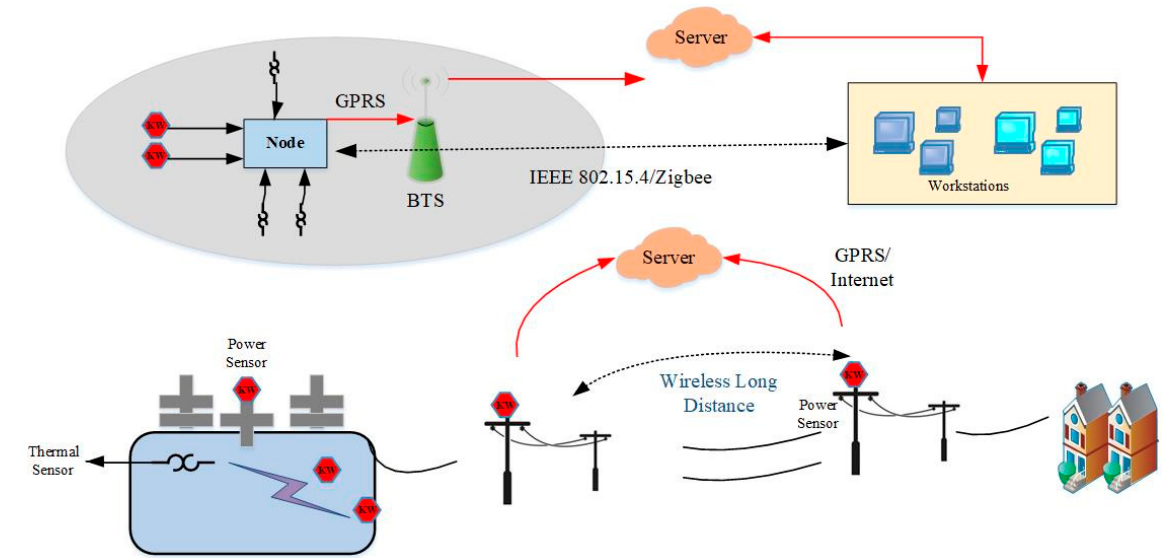
Figure 7. Examples of IoT integration in distribution networks. Table 5. Characteristics of IoT-enabled smart